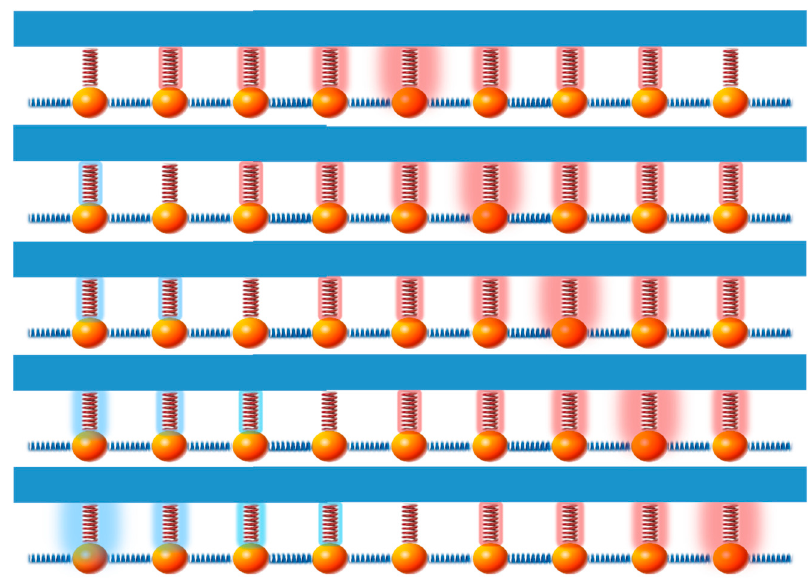
Figure 4. Schematic illustration of the time evolution (top to bottom) of the harmonic chain grounded to a substrate with spatial modulation of the side spring stiffness illustrated as a “pink glow” of varying width when α ą α 0 and a “blue glow” when α ă α 0 .